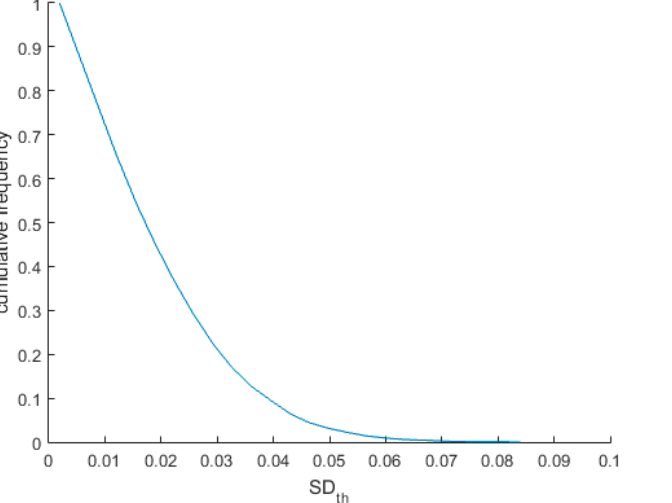
Figure 6. Relative number of bit-cells (cumulative frequency on the vertical axis) that present a value of |SD| equal or greater than SD th (horizontal